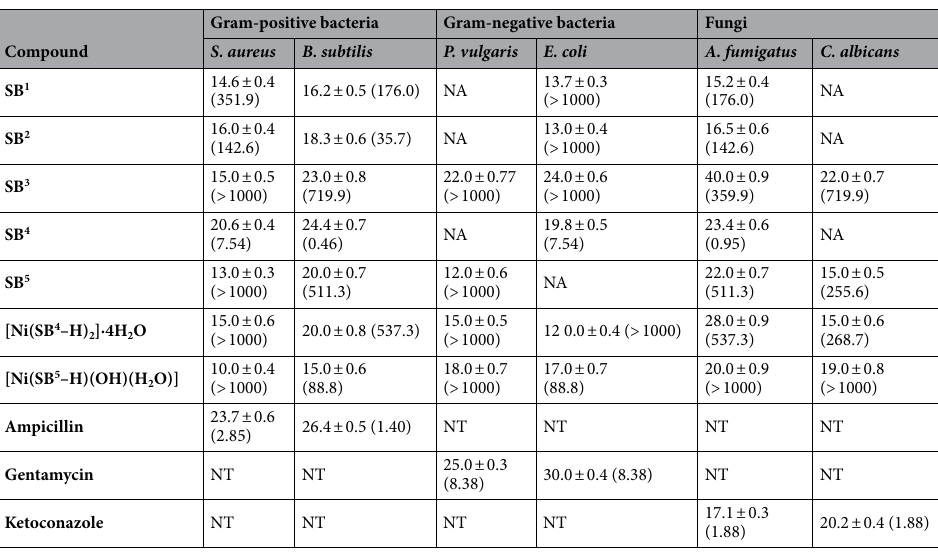
Table 5. Antibacterial and antifungal inhibition zone in mm and the MIC (µM) of the Schiff bases and some of their complexes. NA: no activity, NT: not tested.